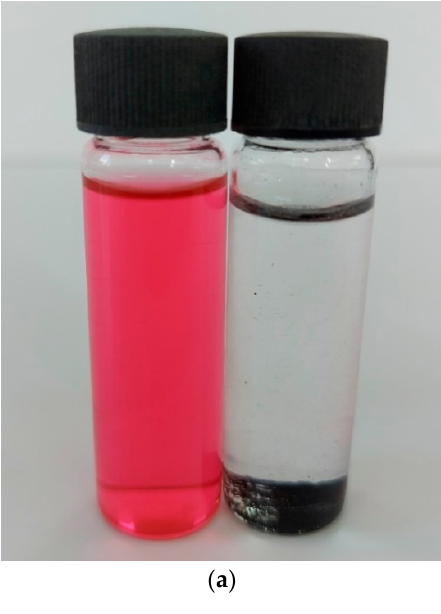
Figure 9. ( a ). Adsorption of M1 dye by the fabricated adsorbent material. ( b ). Adsorption of M2 dye by the fabricated adsorbent